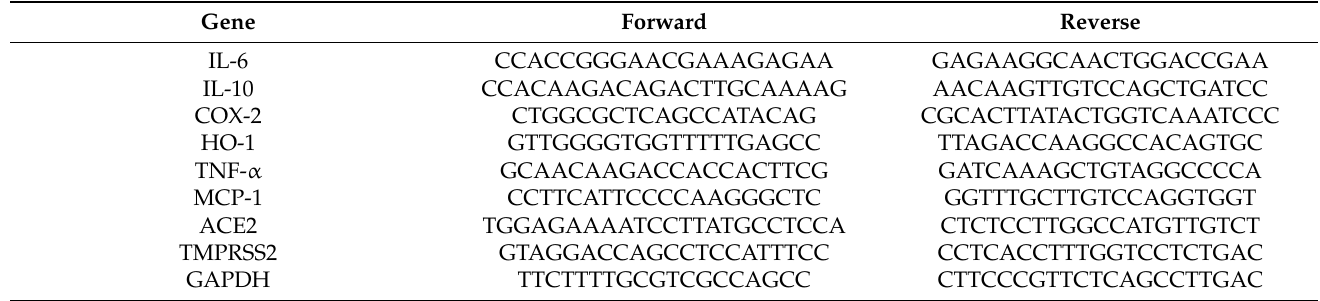
Table 1. Primer sequences used to assess gene expression in human